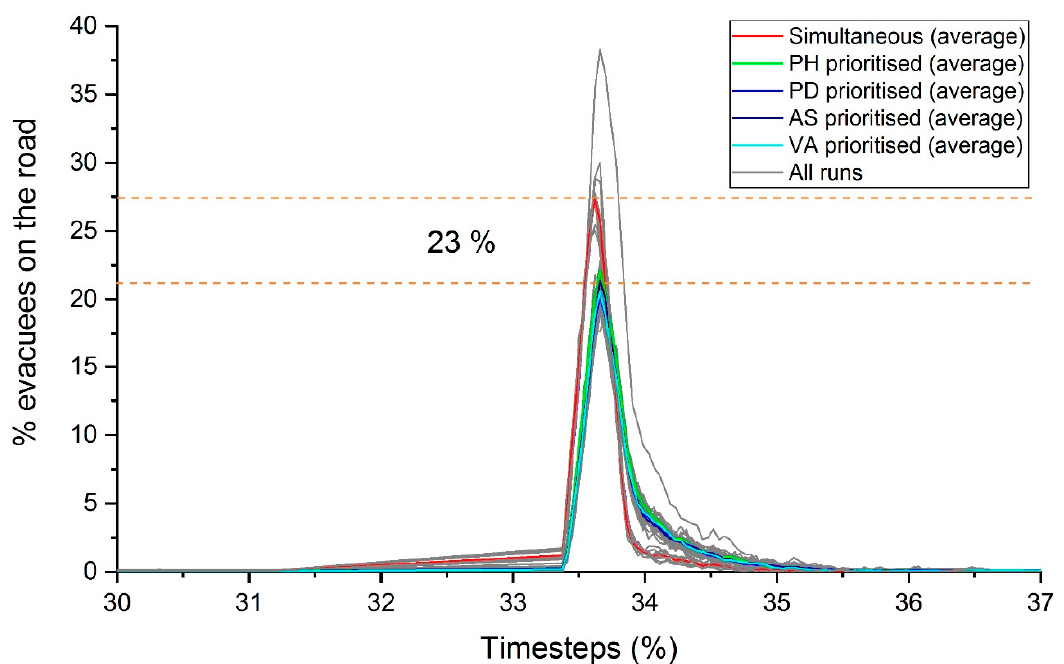
Figure 10. Relative densities of evacuee traffic on the road at the peak evacuation time. ( a ) Simultaneous, ( b ) staged 1, ( c ) staged 2, ( d ) staged 3, ( e ) staged 4 scenario, and ( f ) inset map. Road name: (1) Kaliurang road, (2) Palagan tentara pelajar road (the data is provided in Supplementary Material S8). 3.3. Efficiency in Reducing the Risk Figure 11 presents graphs showing how the evacuation reduces the number of people at risk (%) temporally. The variation in the percentages of the at-risk group (high-risk and medium-risk group)